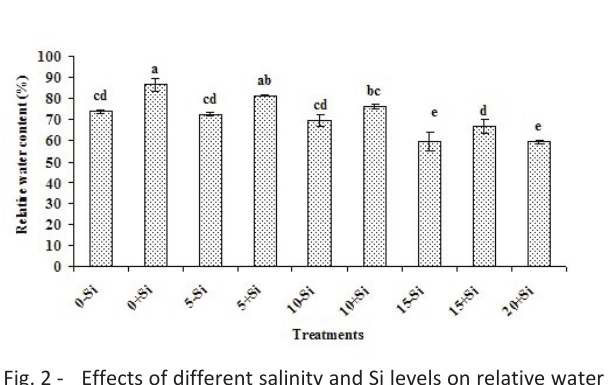
Fig. 2 - Effects of different salinity and Si levels on relative water content in of Poa pratensis after 45 days. 0: control, 5, 10, 15 and 20 dS m -1 as salinity levels; Si: K 2 SiO 3 1mM. Data are mean ± SE . at P<0.05 using LSD test.